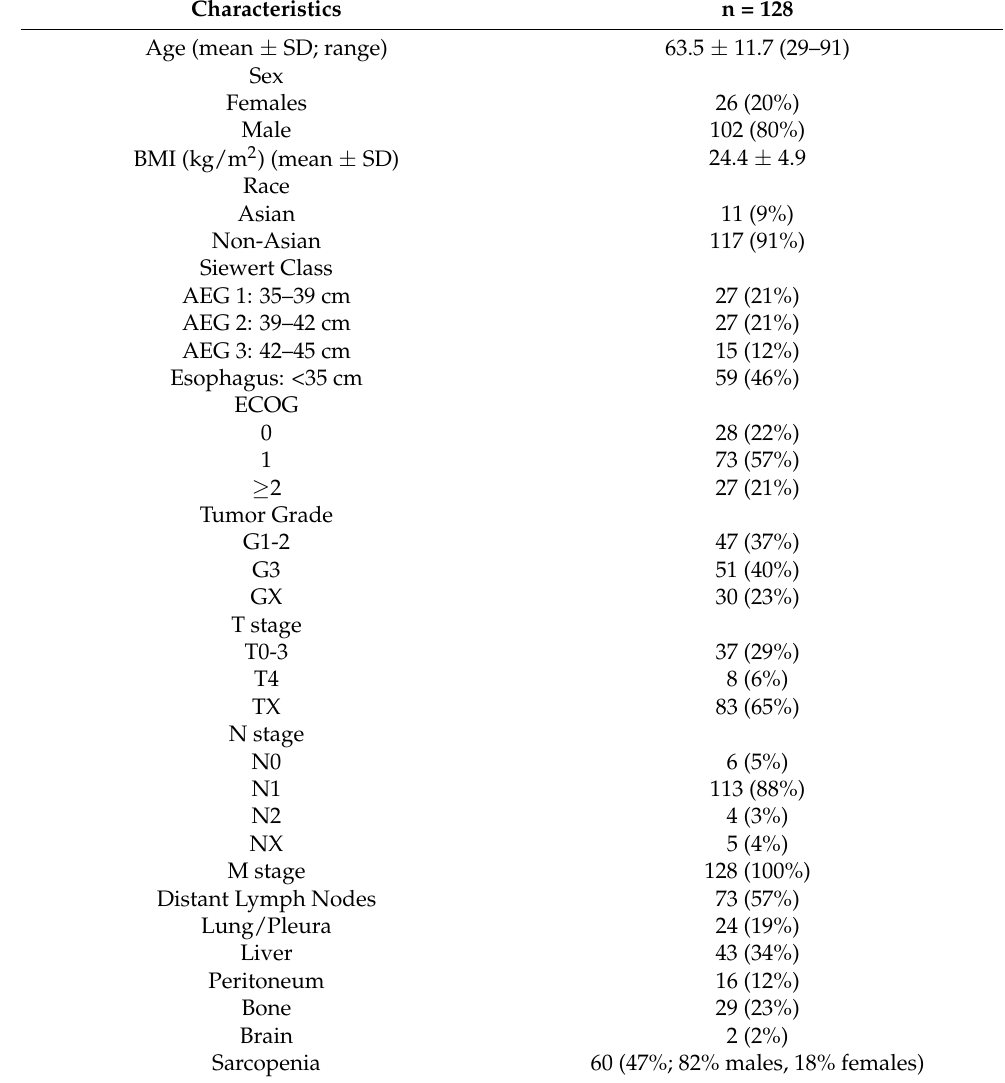
Table 1. Overall demographic